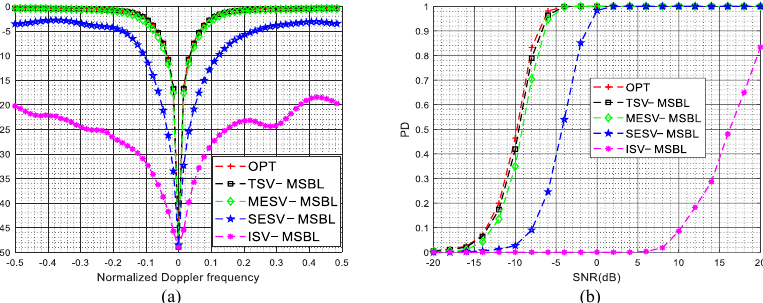
Figure 7. SINR loss curves and PD versus SNR curves in the presence of sensor location errors. ( a ) SINR loss versus the normalized Doppler frequency in the presence of sensor location errors; ( b ) PD versus SNR ( f st = 0.1) in the presence of sensor location errors.